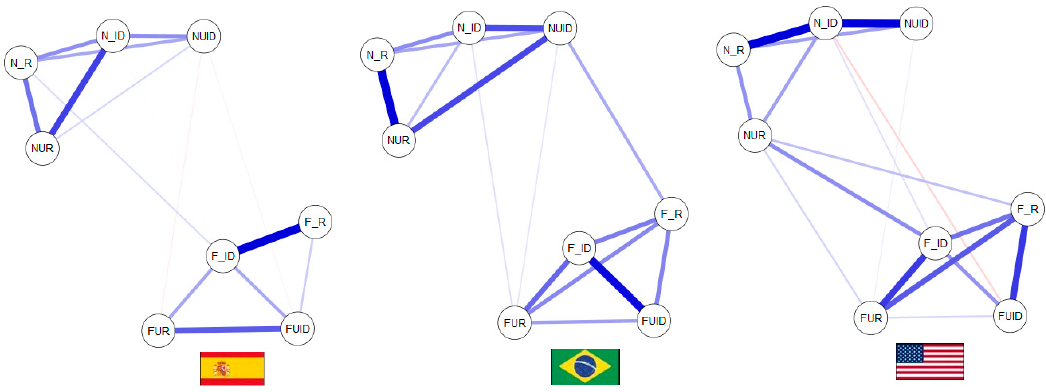
Figure 5. Flow chart according to participant’s country of precedence. Target stimuli: NUR = Unrelated Masked Priming Word–Face; NUID = Unrelated Masked Priming Word–Word; N_R = Related Masked Priming Word–Face; N_ID = Identity Masked Priming Word–Word; FUR = Unrelated Masked Priming Word–Face; FUID = Unrelated Masked Priming Face–Face; F_R = Related Masked Priming Word–Face; F_ID = Identity Masked Priming Face–Face.